Question: Reading the figure, is the described quantity rising or falling?
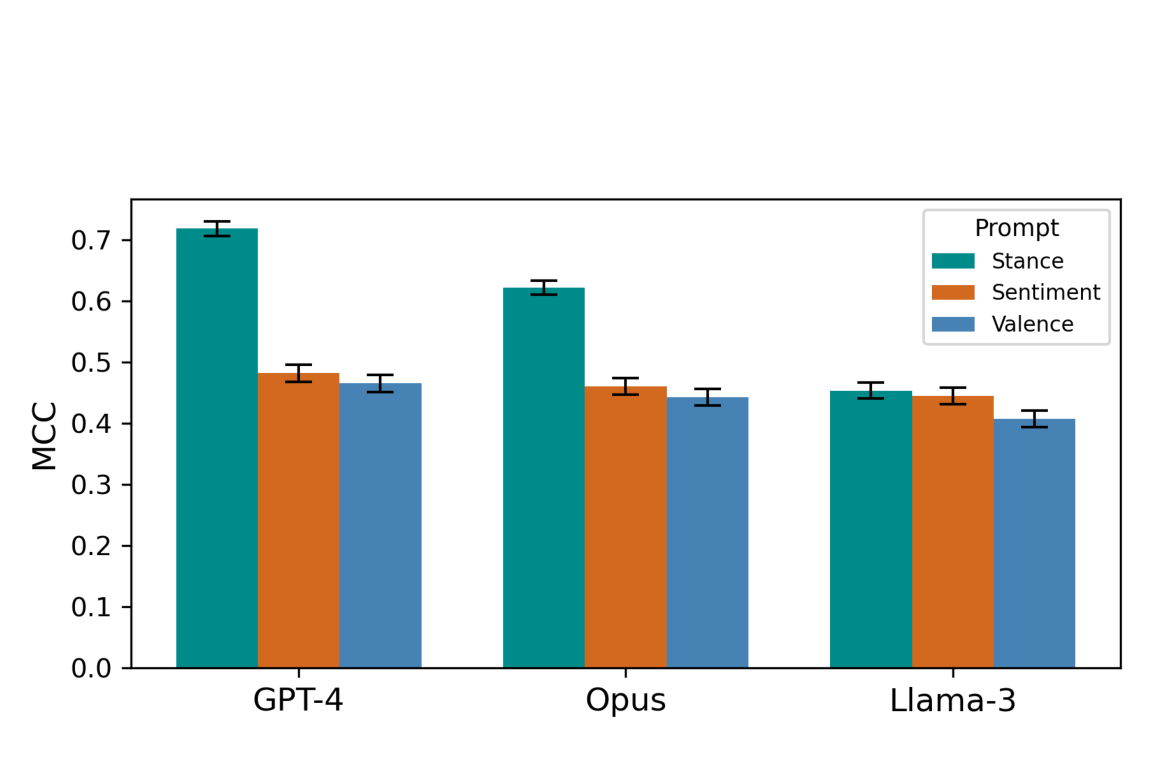
Answer: increasing